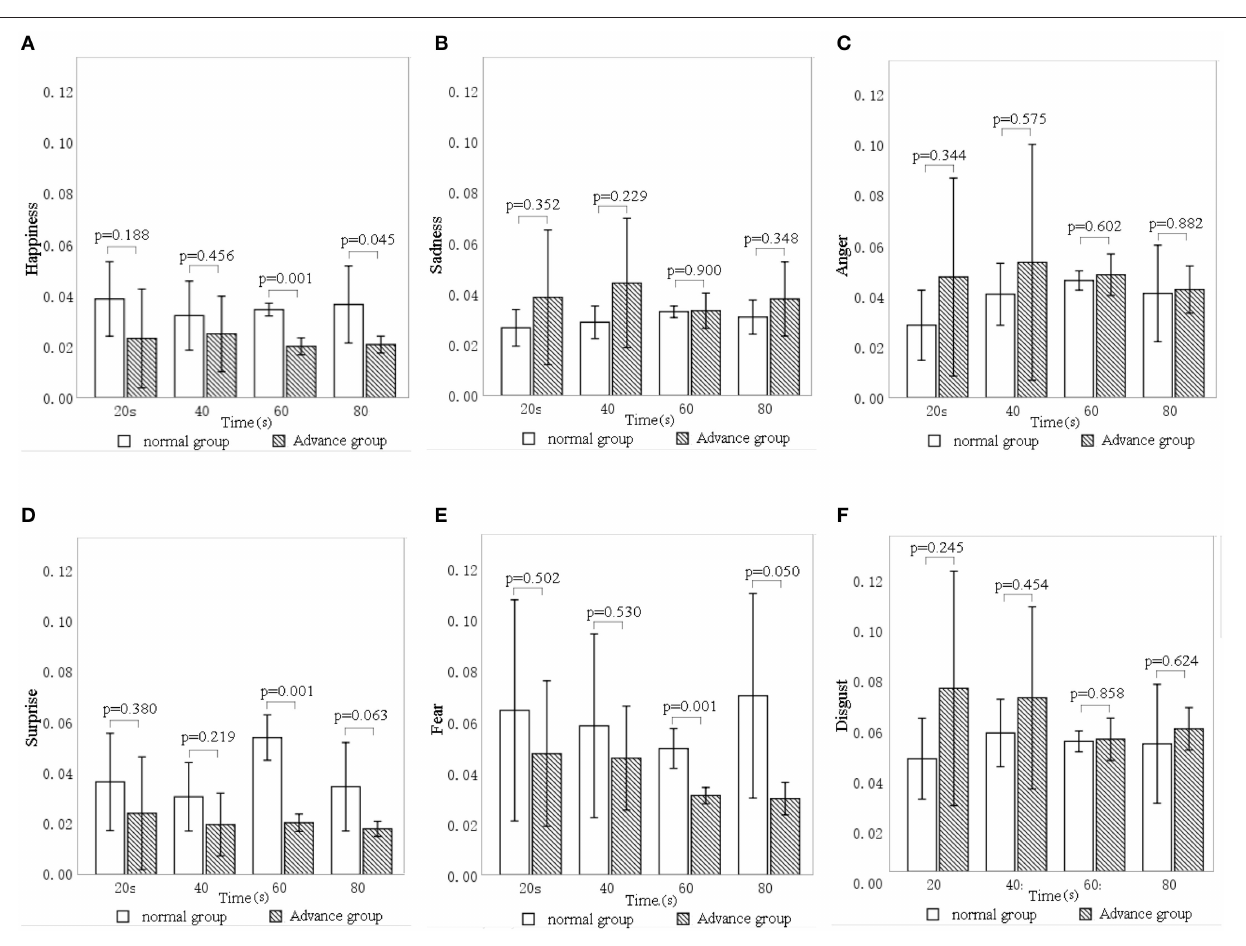
Frontiers in Psychology |